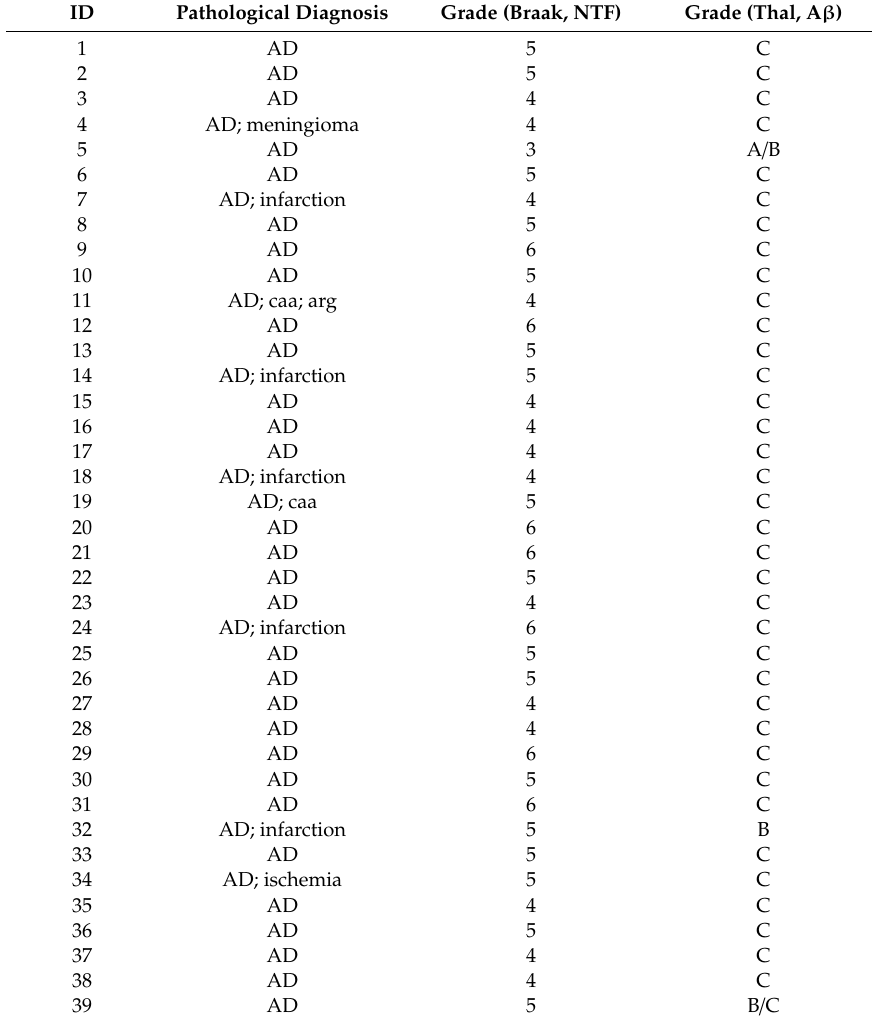
Table 2. Alzheimer’s disease (AD) neuropathological